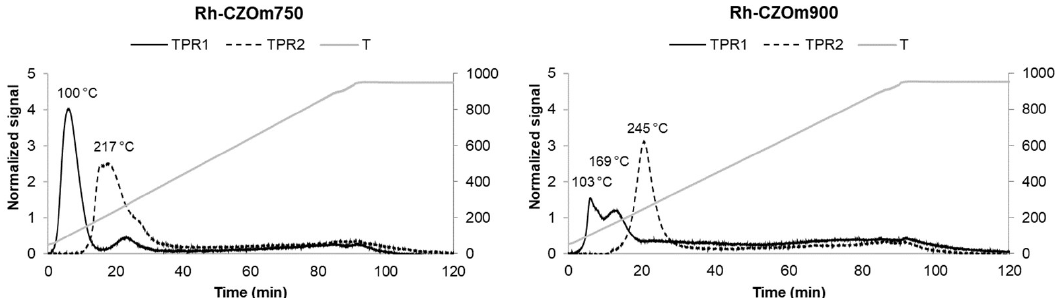
Figure 4. Temperature-programmed reduction of Rh-CZOm900 and Rh-CZOm750. The dotted line represents the temperature-programmed reduction carried out after temperature-programmed oxidation.